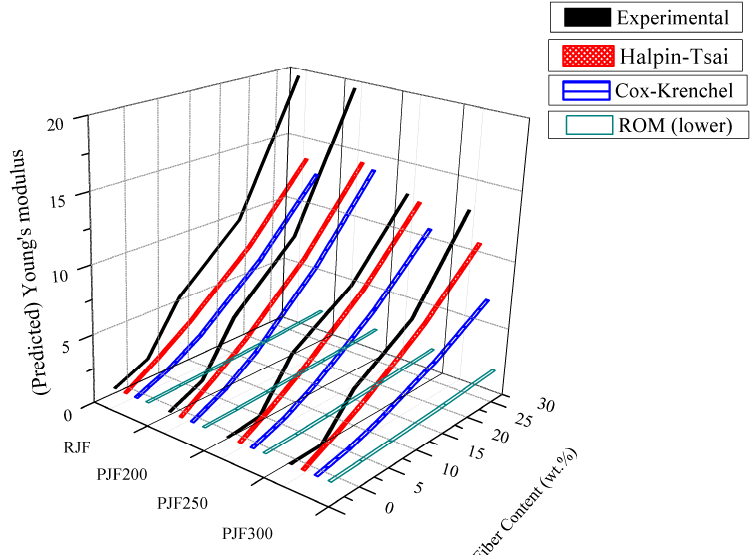
Figure 6. Experimental and predicted Young’s modulus of JF-reinforced ASKLTPU modelled using Halpin-Tsai, Cox-Krenchel, and the rule of mixture (lower).